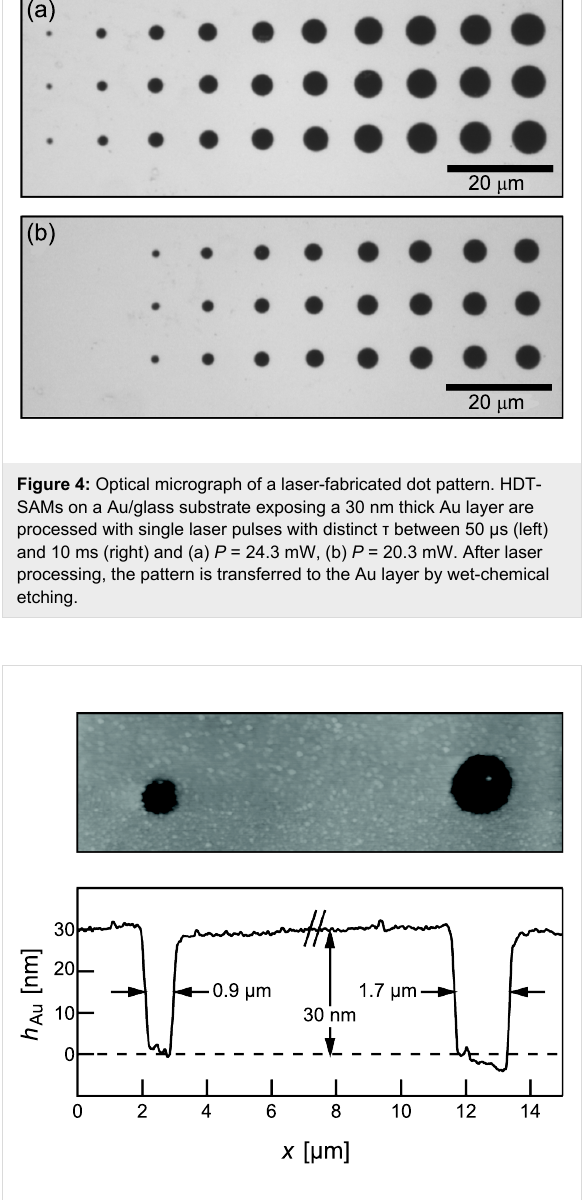
Figure 5: AFM data from patterning experiments with HDT-SAMs on Au/glass substrates exposing a 30 nm thick Au layer. The structures were fabricated by using single laser pulses at P = 24.3 mW and with distinct τ of 50 µs (left) and 100 µs (right). Pattern transfer to the Au layer was carried out by wet-chemical etching. Diameters refer to values at